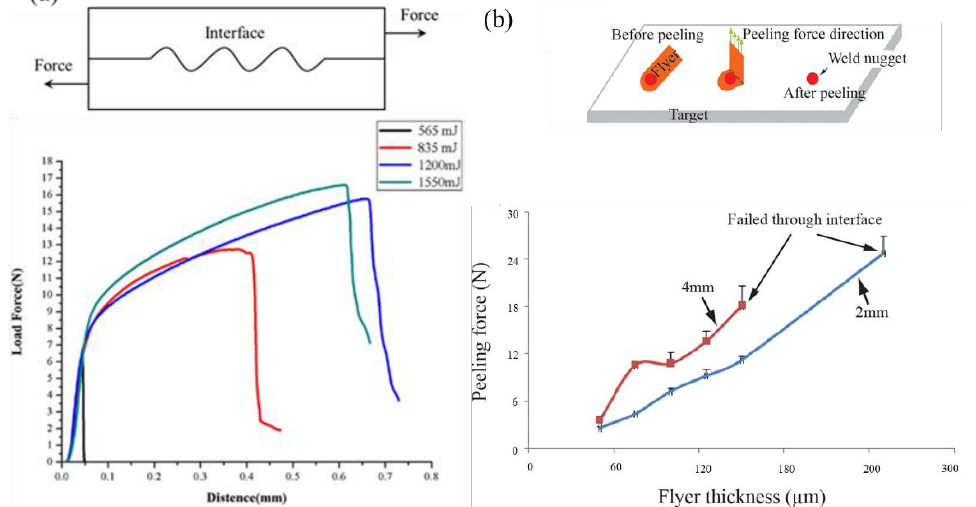
Figure 15. Test method for bonding force of welded joints ( a ) shearing test and result (reproduced from [28], with permission of Elsevier 2019); ( b ) peeling test and result (reproduced from [24] with permission of Laser Institute of America 2016).